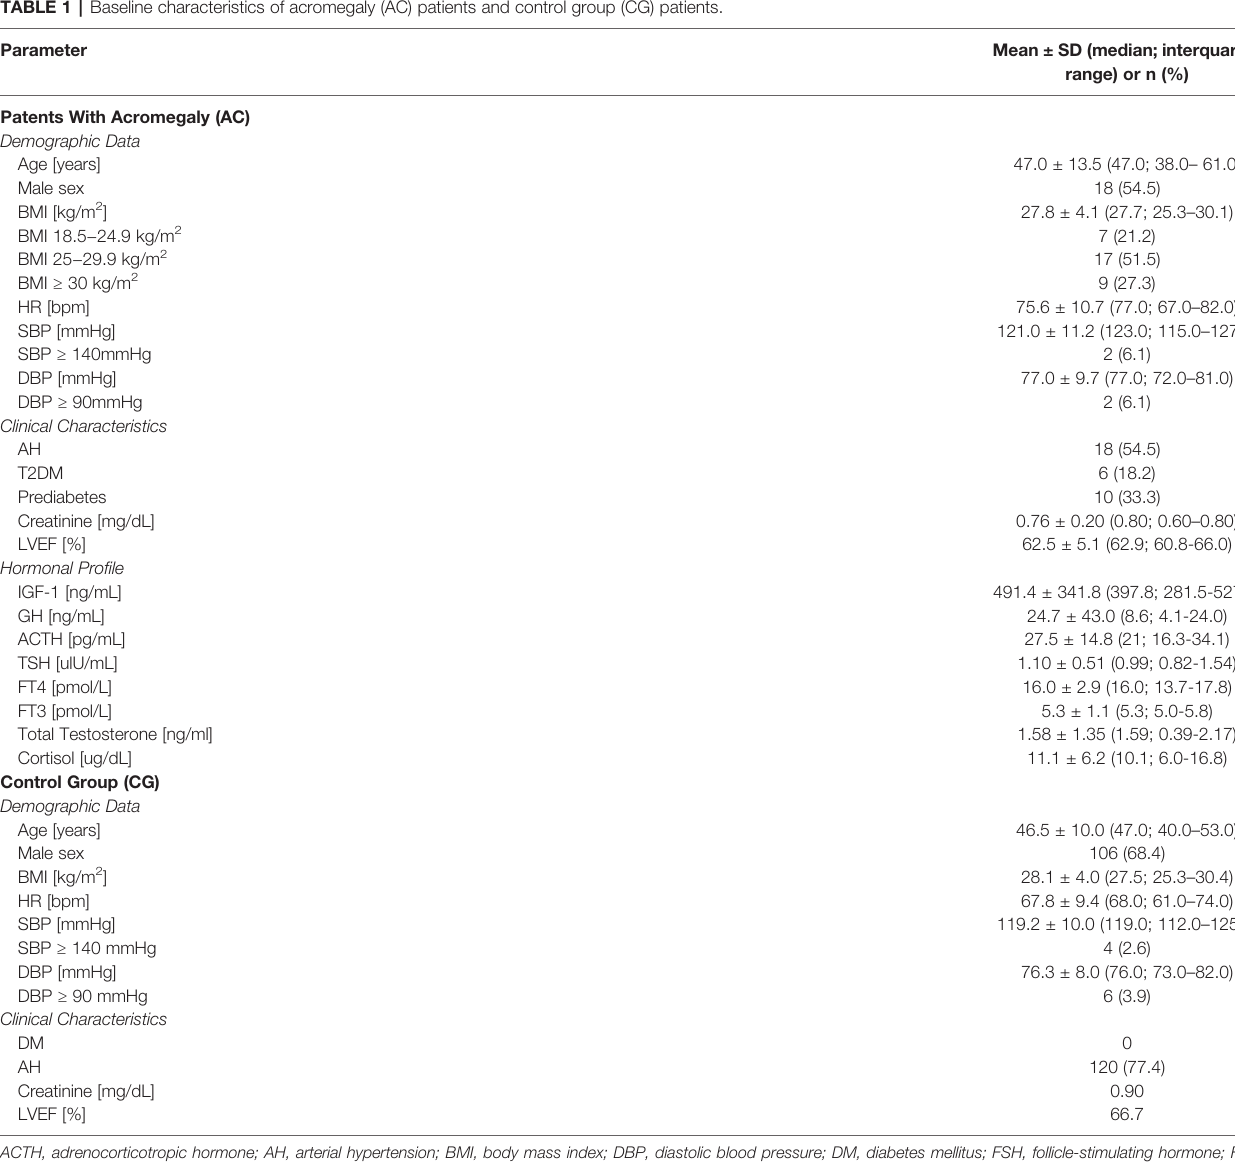
A comparative analysis of the CG and AC patients in terms of other selected parameters has been presented in Table 5 . ICG